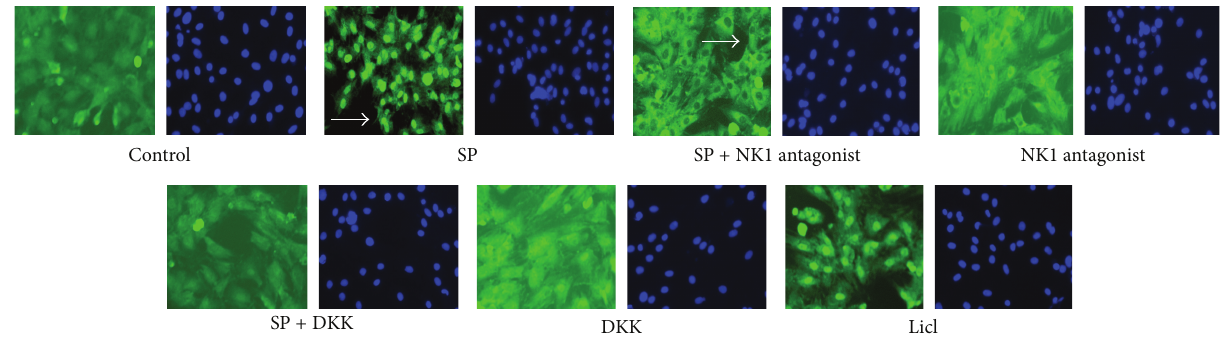
Figure 4: Effect of SP on the nuclear translocation of 𝛽 -catenin in BMSCs. SP exhibited a stable ability to activate 𝛽 -catenin nuclear translocation. In BMSCs, nuclear 𝛽 -catenin was not evident, whereas its nuclear localization was clearly observed following SP treatment, as indicated by FITC-linked 𝛽 -catenin (indicated by the arrow in the SP group). With combined NK-1 antagonist and SP treatment, nuclei appeared relatively dark (indicated by the arrow in the SP + NK-1 antagonist